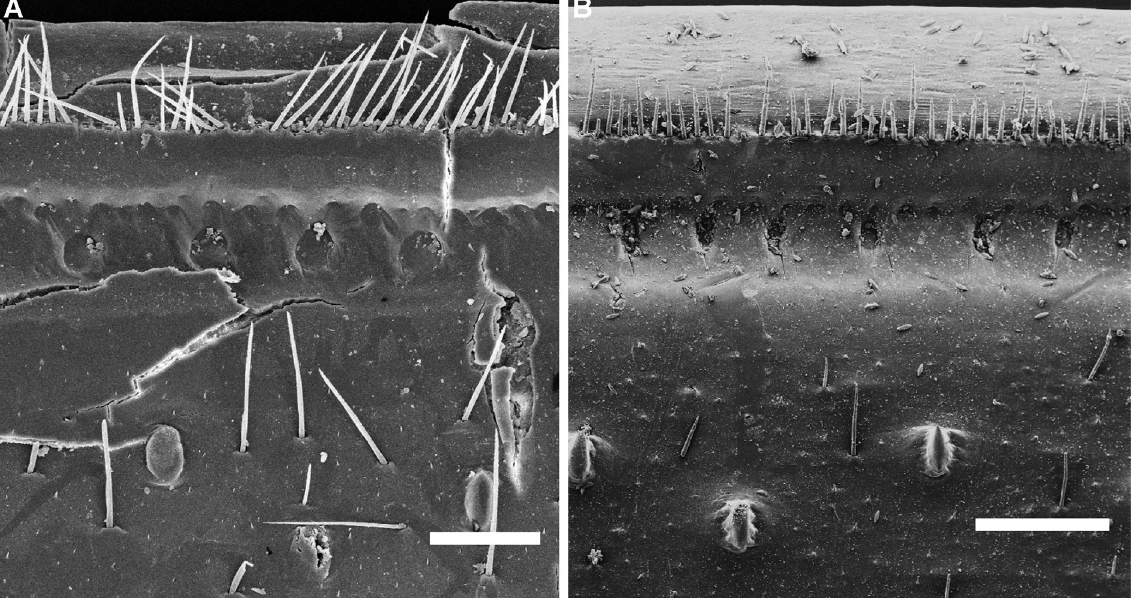
Fig. 10. Scanning electron micrographs of the endoterga of midbody rings. A . Zoosphaerium masoala sp. nov., holotype (FMNH-INS 3195651). B . Z. spinopiligerum sp. nov., holotype (FMNH-INS 3119885). Scale bars = 100